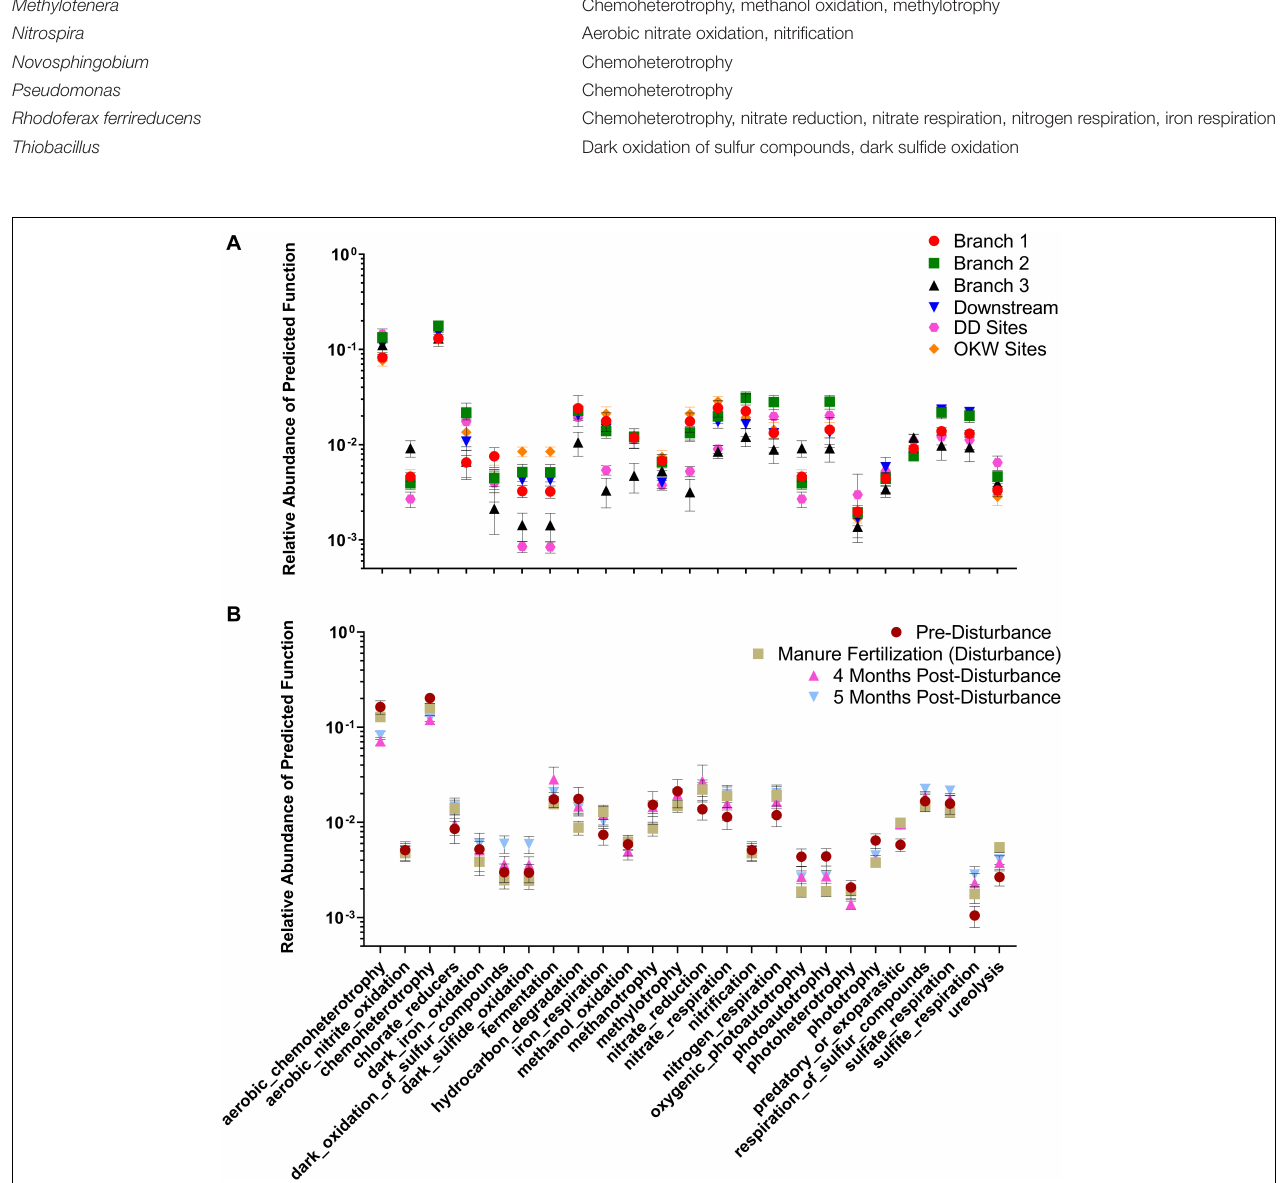
Frontiers in Microbiology |